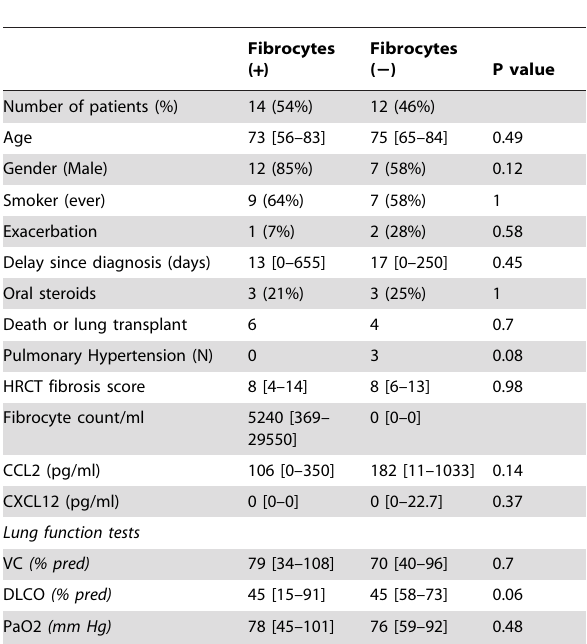
Table 3. Clinical and functional characteristics of the IPF patients according to the detection of fibrocytes in BAL.